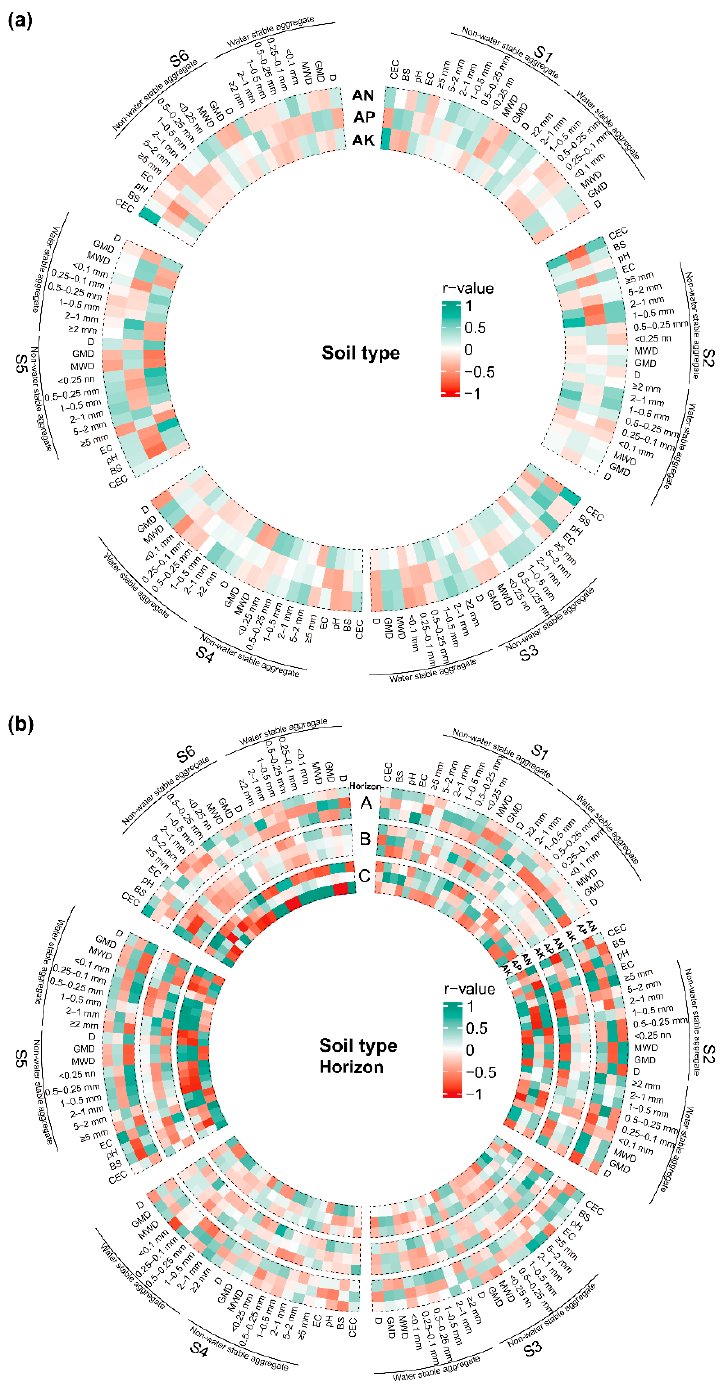
Figure 4. Pearson’s correlation analysis of soil-available nitrogen (AN), soil-available phosphorus (AP), soil-available potassium (AK), soil chemical and aggregate properties (soil cation exchange capacity, CEC; degree of base saturation, BS; pH value, pH; electric conductivity, EC), and aggregate properties (non-water-stable aggregate content and water-stable aggregate content, soil aggregate of mean weight diameter, MWD; geometric mean diameter, GMD; fractal dimensions, D) in 6 soil types (( a ); subalpine meadow soil, S1; meadow soil, S2; dark brown soil, S3; brown soil, S4; yellow-brown soil, S5; and cinnamon soil, S6) and 3 horizons (( b ); leaching horizon, A; sediment horizon, B; and parent material horizon, C). The results with green and red squares show significant positive and negative pairwise relationships, respectively.